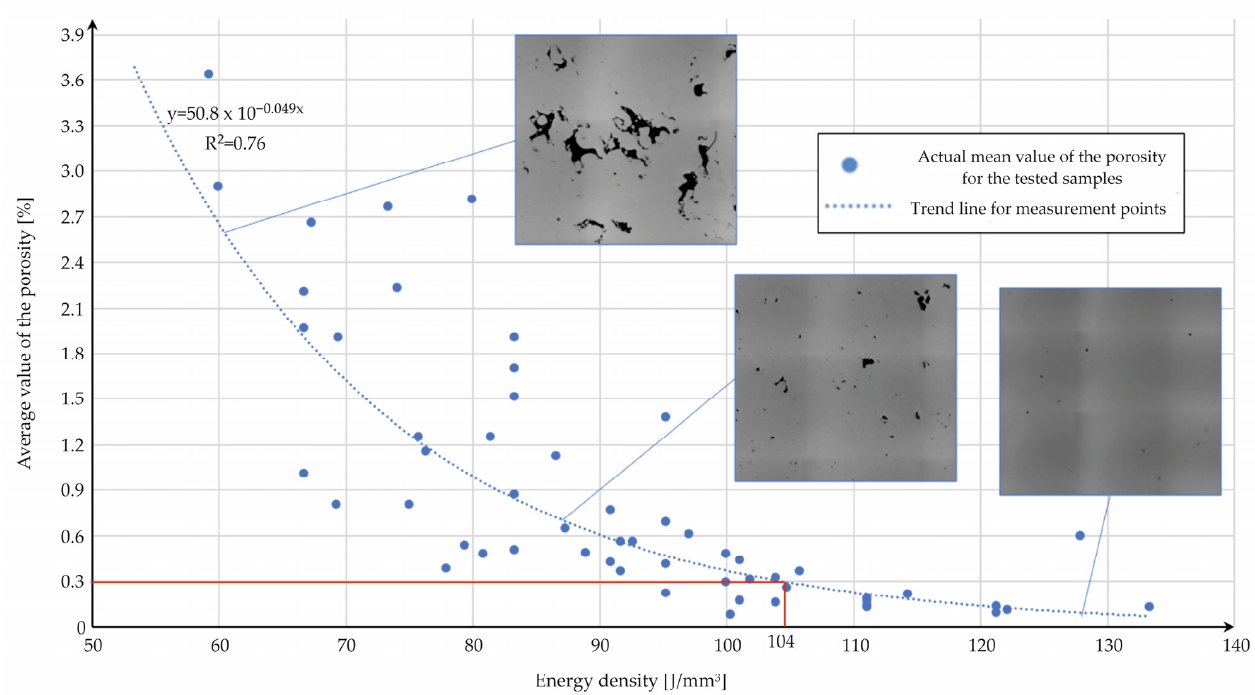
Figure 4. Porosity values for AM samples as a function of the energy density observed during the microscopical investigation.